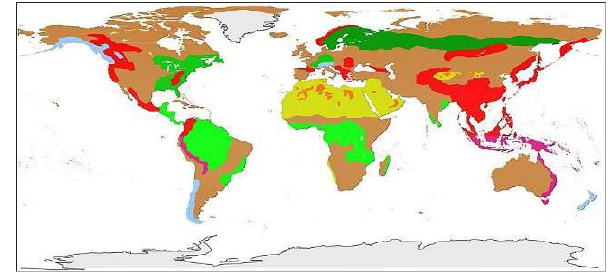
Figure 1. Detected acquisition areas for the TanDEM-X Change